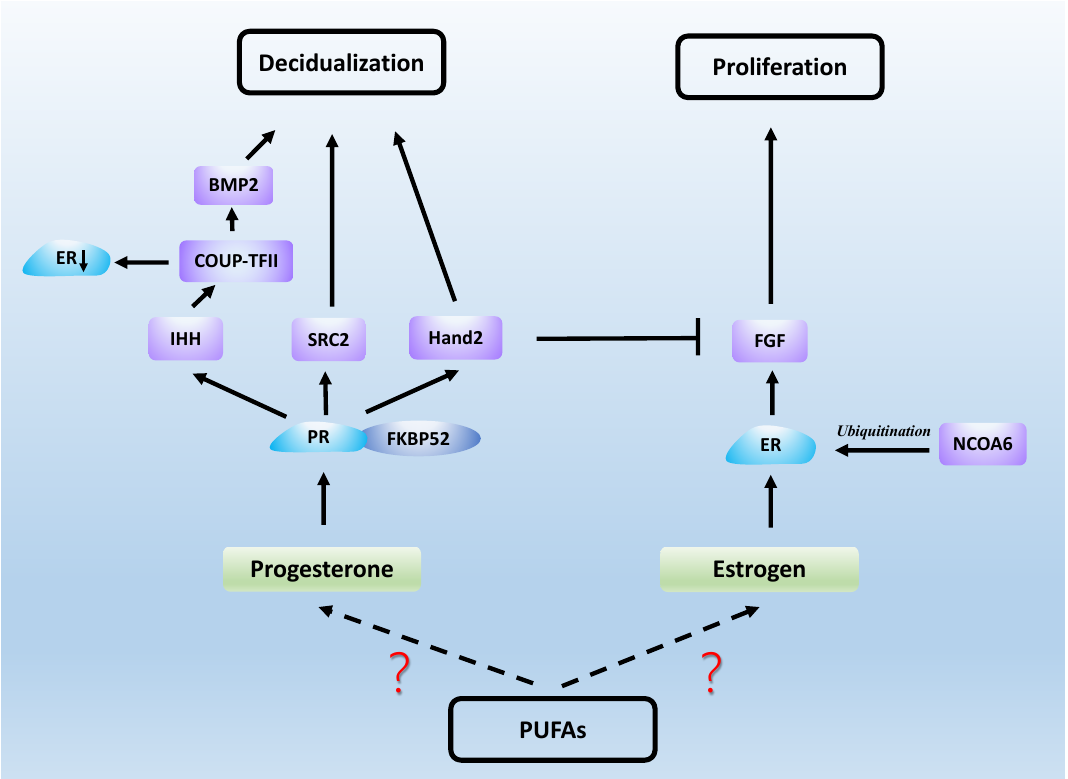
Figure 2. Steroid hormones work with a series of signaling molecules to generate uterine